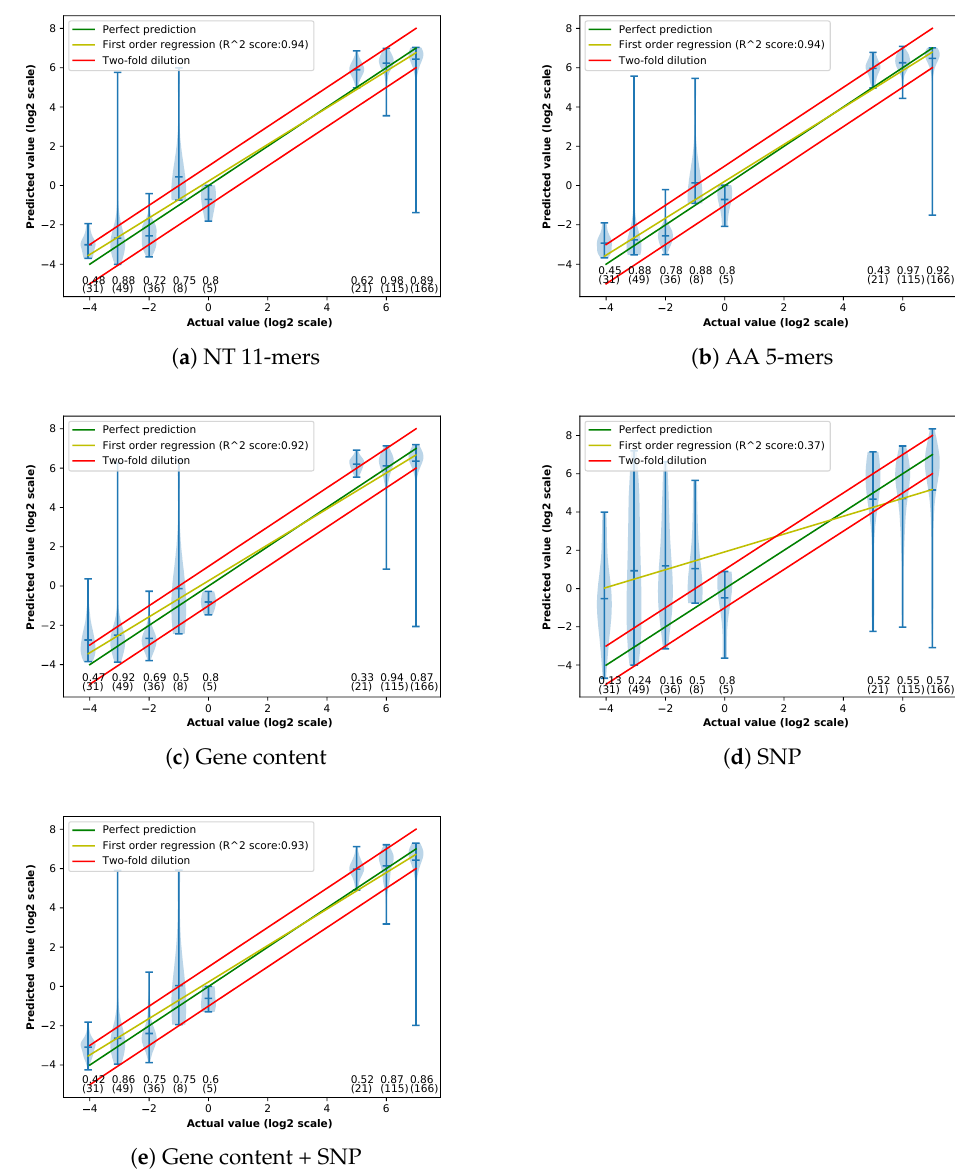
Figure A5. Violin plots of performances of different methods in predicting MIC of tetracycline for C. jejuni . X-axis is the actual value and y-axis is the predicted value. Each violin shows the kernel density estimation distribution of predictions for one MIC actual target value. Below each violin, the ± 1 two-fold dilution accuracy of that target value is mentioned, and below that, the number of strains with that target value is mentioned in parentheses. The green line represents the perfect prediction and the yellow line represents the first order regression between the actual values and predicted values. The red lines represent the limits of the perfect predictions’s ± 1 two-fold dilution. ( a ) NT 11-mers, ( b ) AA-5mers, ( c ) gene content, ( d ) SNP, ( e ) gene content +